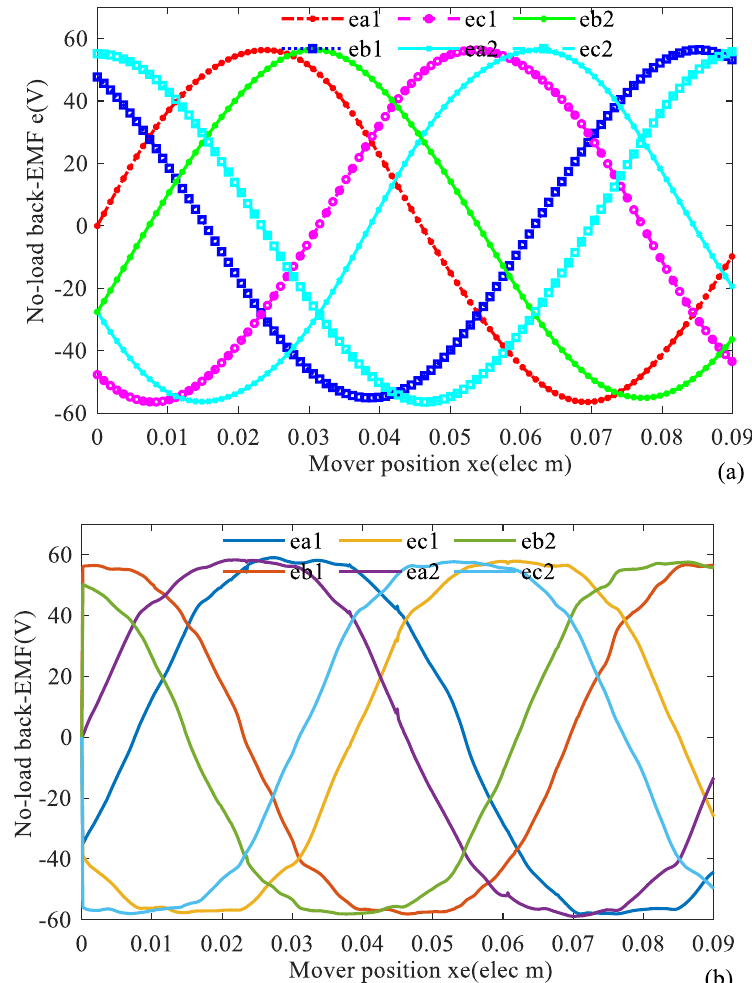
Figure 21. No-load back-EMF wave of DTP-FL winding ( a ) analytical method, ( b ) FEM method.